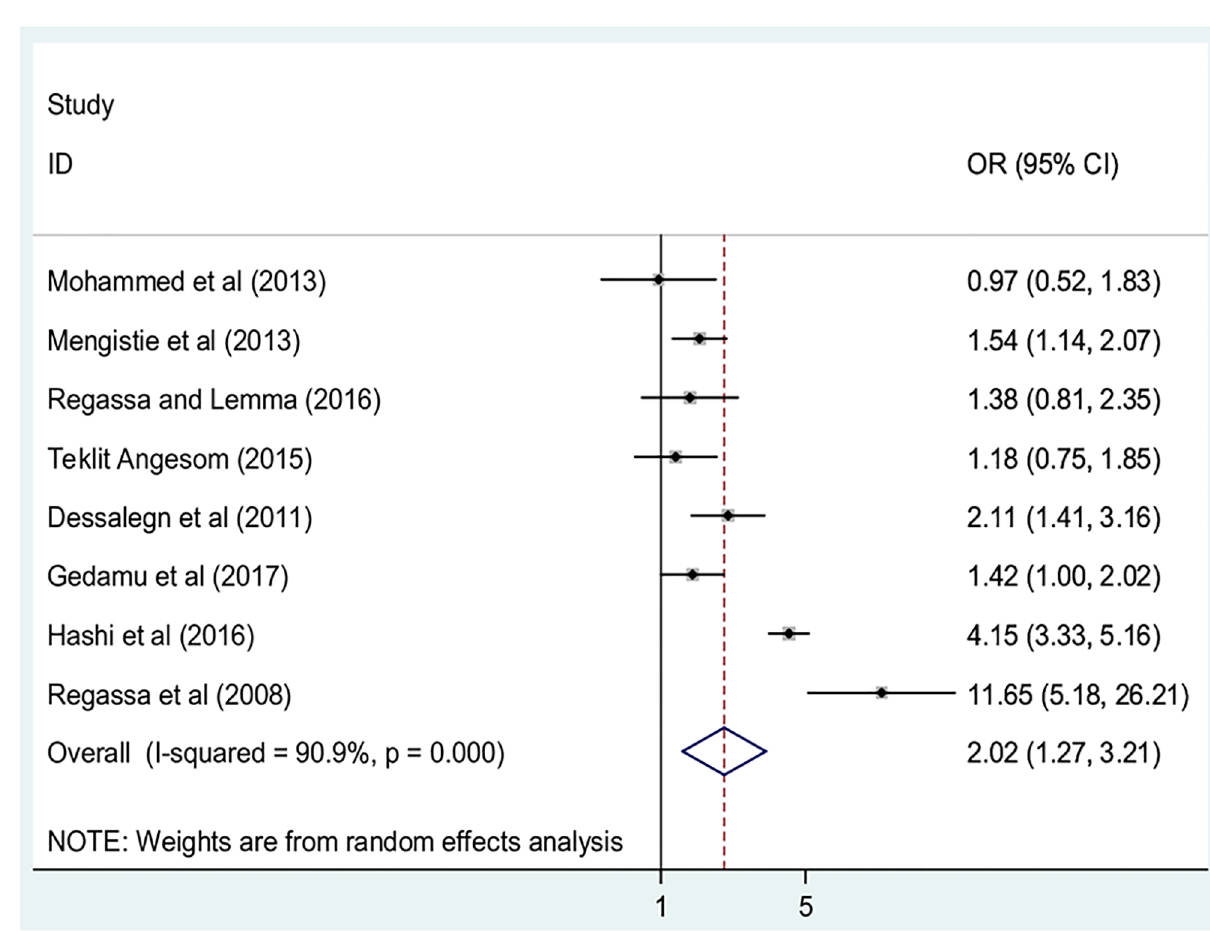
Fig 5. The pooled odds ratio of the association between latrine availability and childhood diarrhea in Ethiopia.